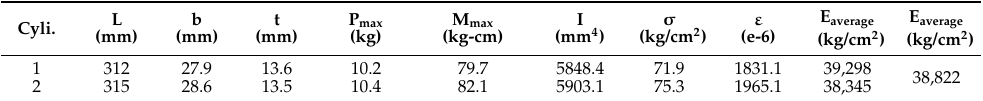
Table 3. Results of the experiment tension on the fibrocement panel.